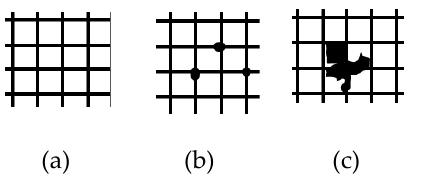
Figure 2. Evaluation levels representation of the adhesion test, adapted based on ref [26]: ( a ) low level (level 0); ( b ) maximum accepted level (level 1); ( c ) high level (level 4).